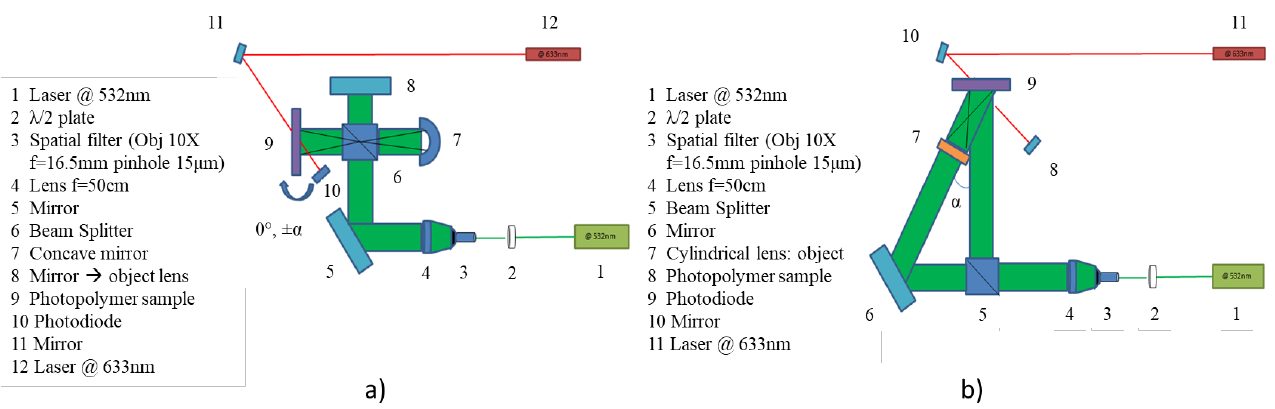
Figure 5. ( a ) Experimental set-up for volume phase holographic spherical lenses recording; ( b ) Experimental set-up for volume phase holographic cylindrical lenses off-axis recording.